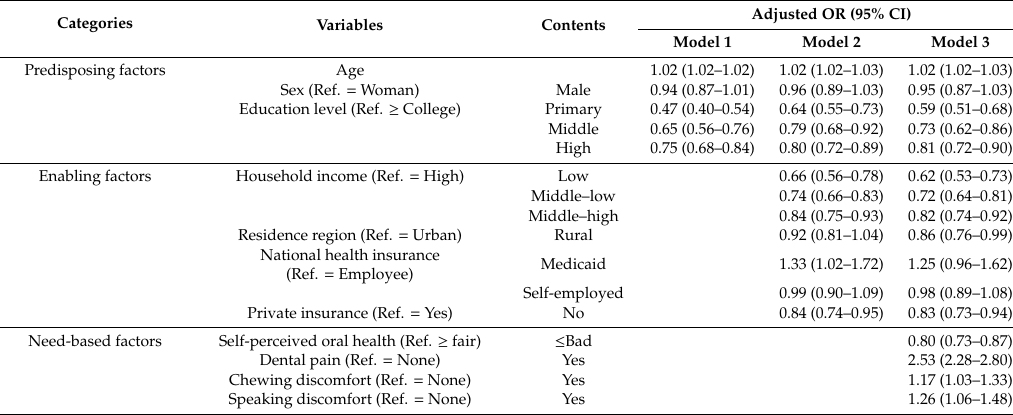
Impact of the predisposing, enabling, and need factors related to oral healthcare service utilization.